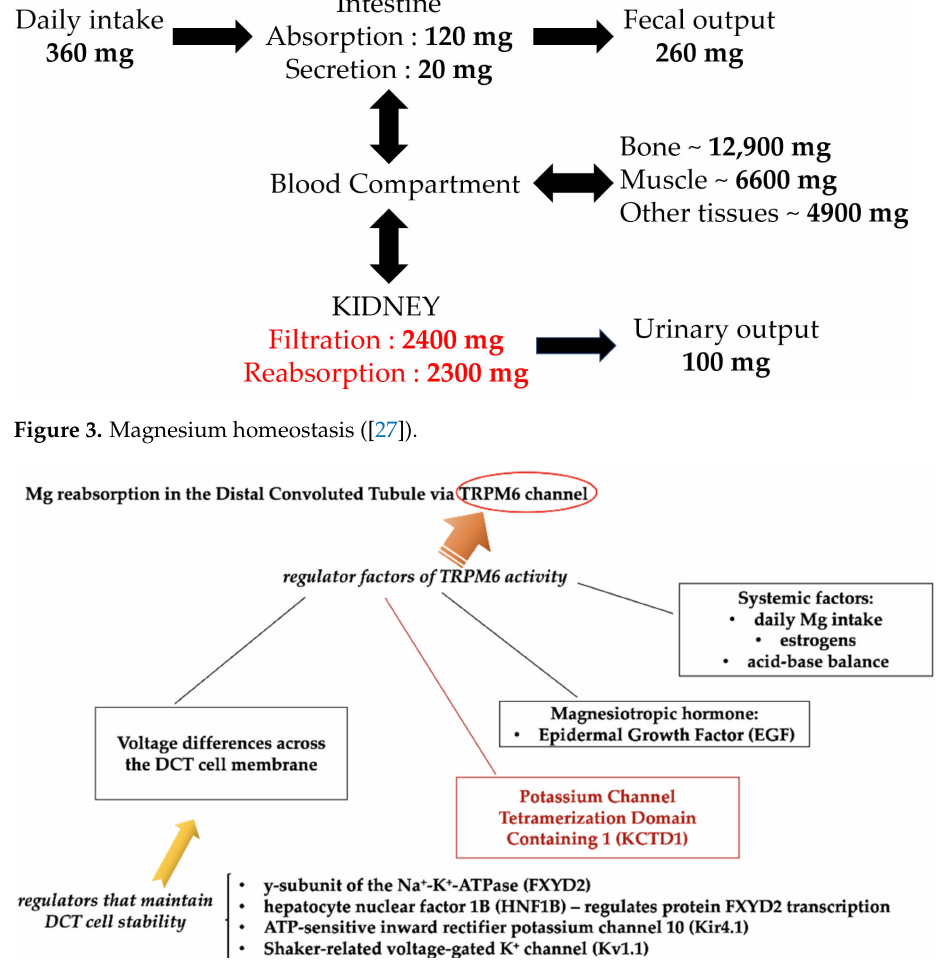
Figure 4. Magnesium regulatory system within the distal convoluted tubule (modified after: [33]). TRPM6: melastatin-related transient receptor potential cation channel